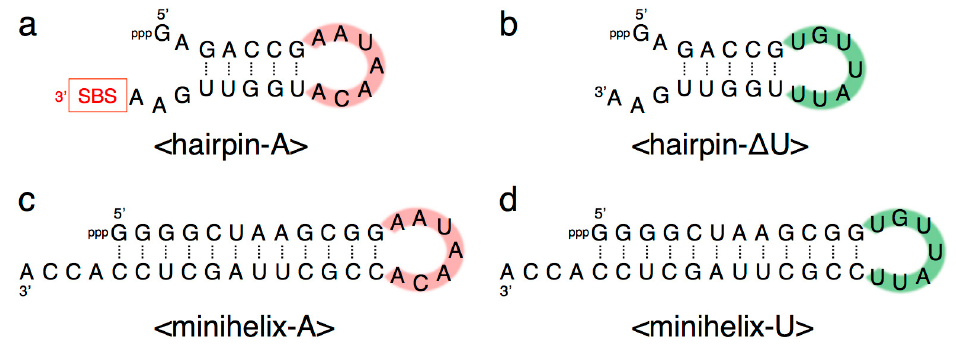
Figure 7. Composition of ( a ) <hairpin-A>, ( b ) <hairpin- ∆ U>, ( c ) <minihelix-A>, and ( d ) <minihelix-U>. Complementary seven-membered single stranded nucleotides (5 ′ -AAUAACA-3 ′ and 5 ′ -UGUUAUU-3 ′ ) are colored in pink and green, respectively. SBS, 3 ′ -terminal substrate-binding site.